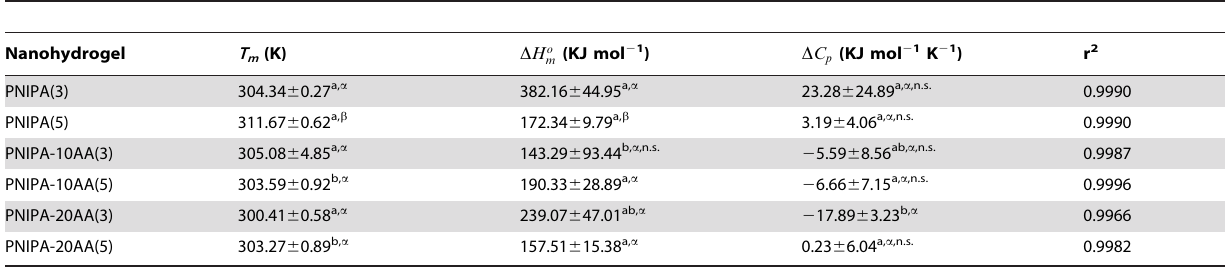
Table 3. Parameters generated from fitting the Equation 13 to experimental data of optical density variation in PNIPA/AA nanohydrogel suspensions as a function of temperature.